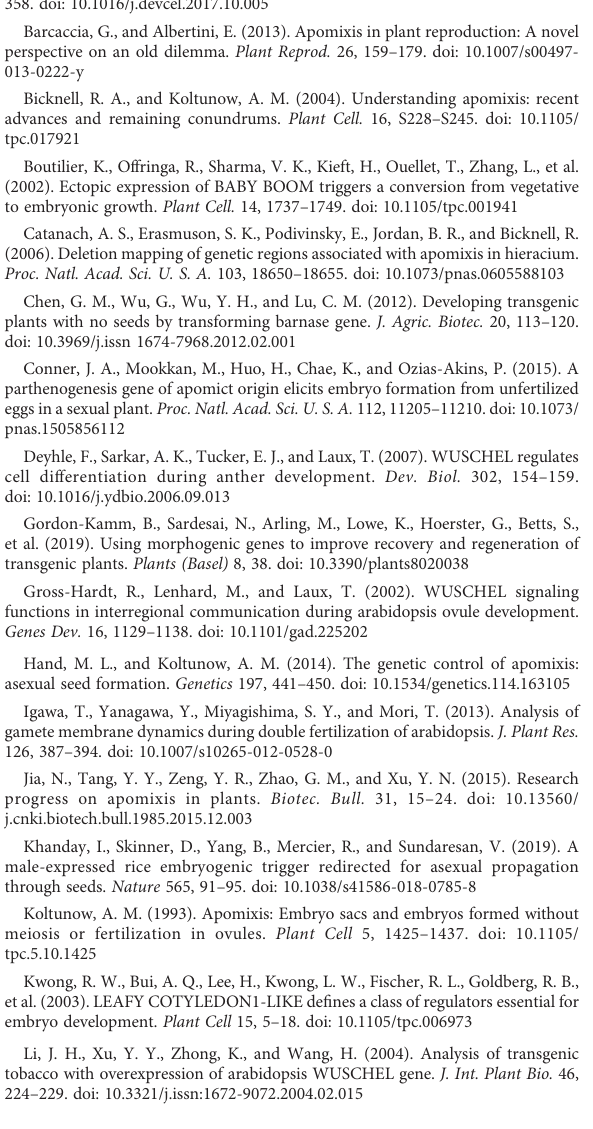
Double-seedings and embryo-free seeds induction in transgenic rice.